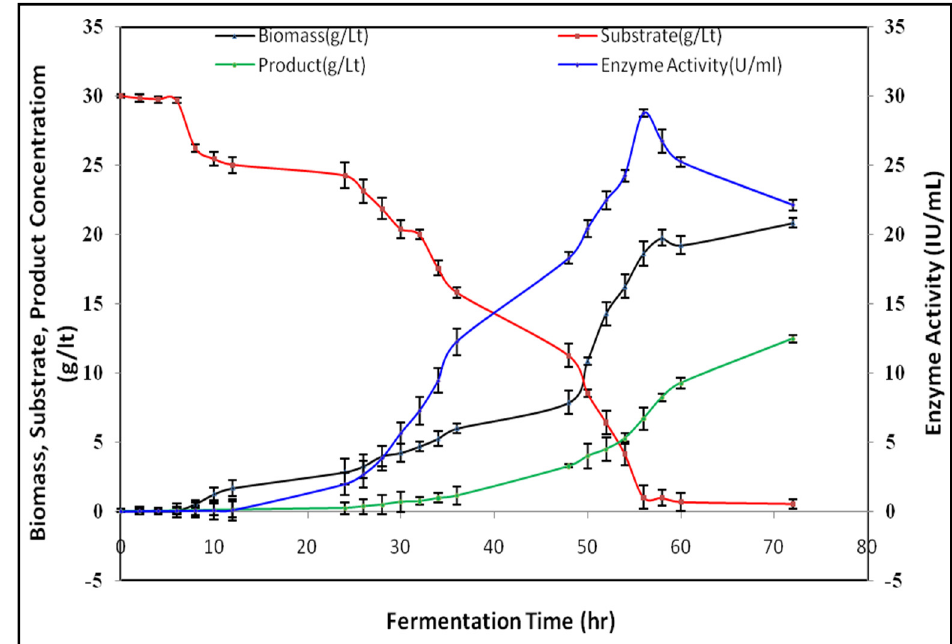
Figure 5. Batch fermentation.